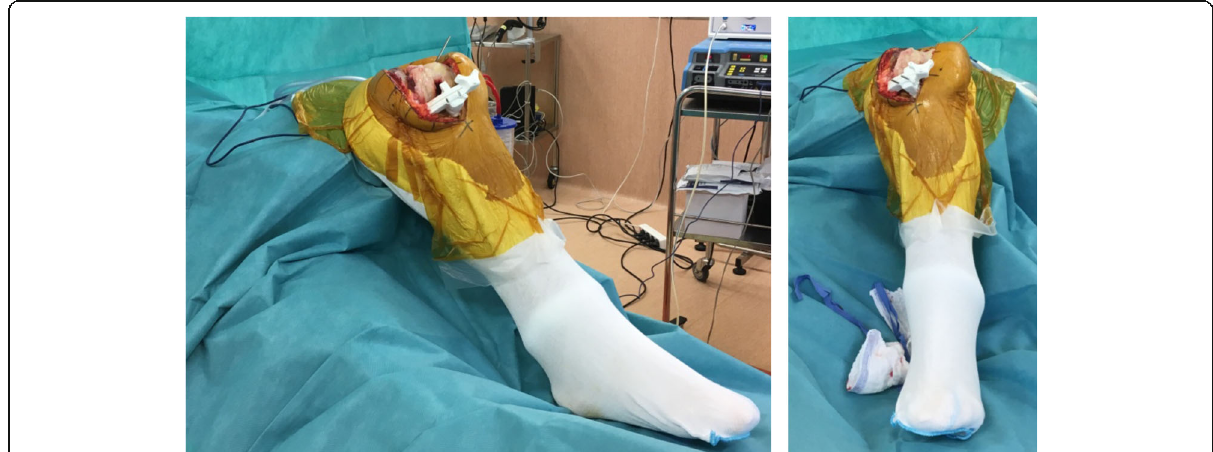
Fig. 2 Fixation of the tibial PSI cutting